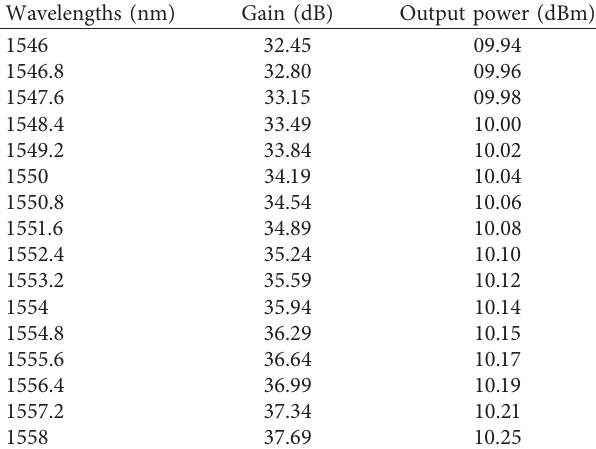
Table 1: Output readings of optical network.